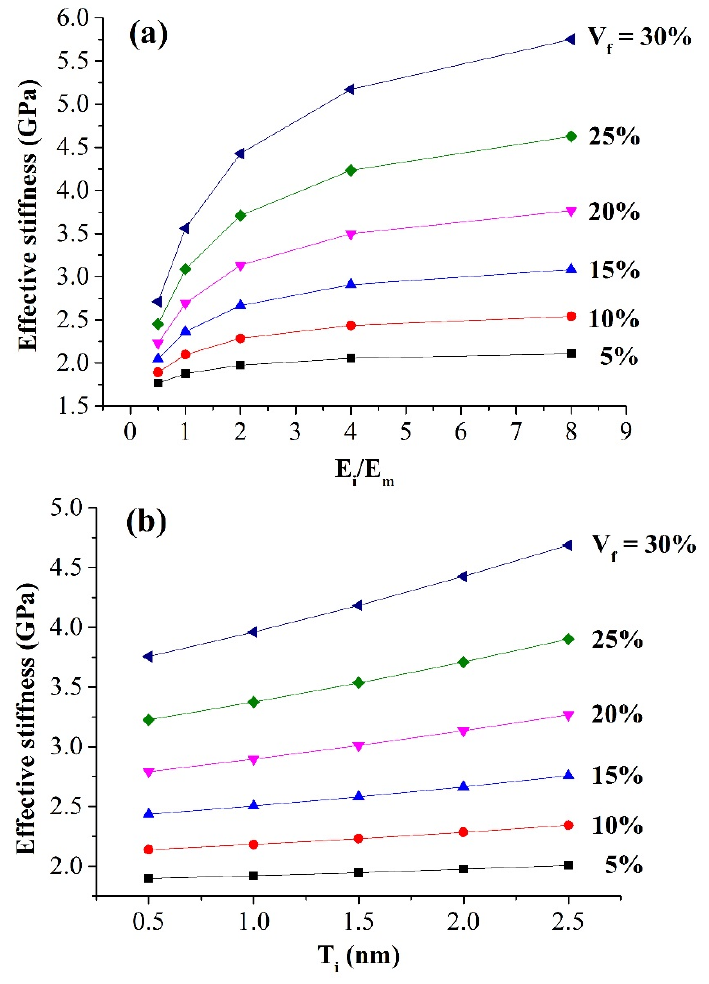
Figure 3. Effect of ( a ) interphase modulus and ( b ) interphase thickness on the effective stiffness of